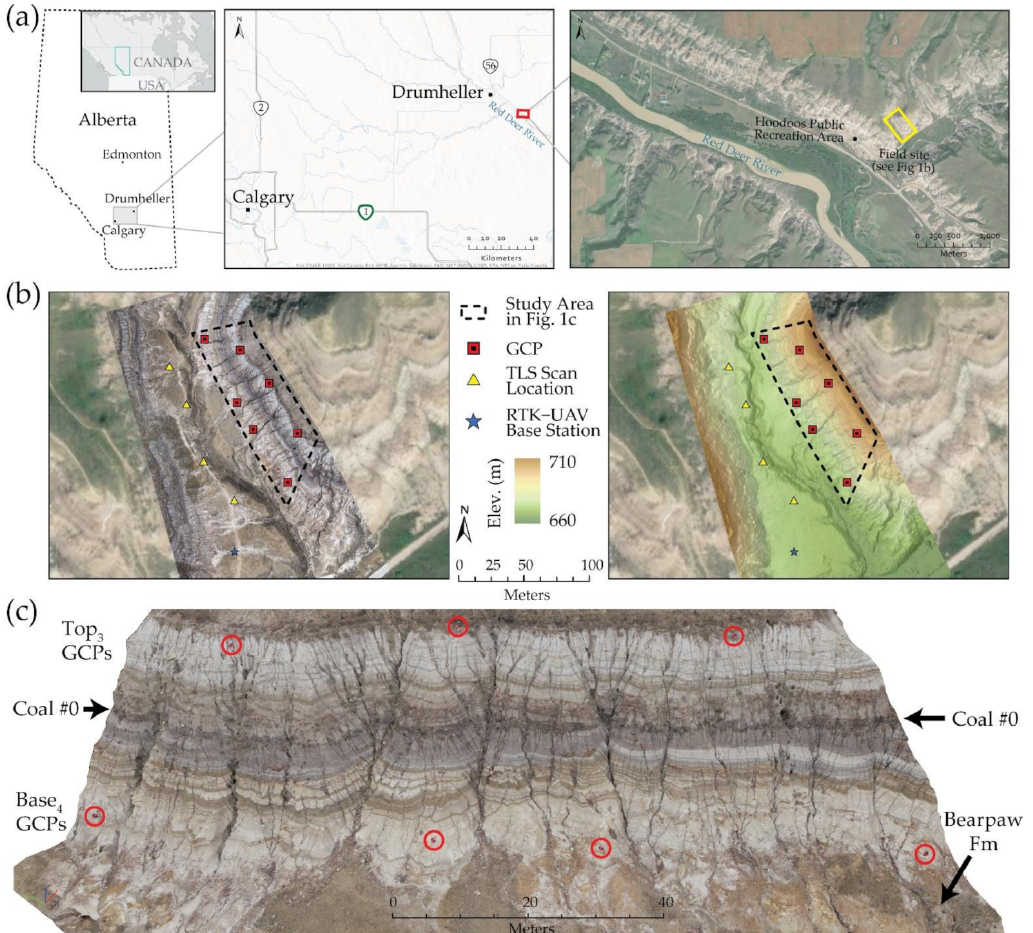
Figure 1. Study area overview; ( a ) site location near Hoodoos Public Recreation Area, 12 km SE of Drumheller, AB; ( b ) UAV-SfM orthomosaic and digital surface model (DSM) of study area with TLS scan locations; ( c ) 3D model of study slope (~70 ◦ average), GCP distribution with Top 3 along accessible ridge, Base 4 along bottom, and regional features identified (i) Coal #0 and (ii) erosional basal contact with the underlying Bearpaw